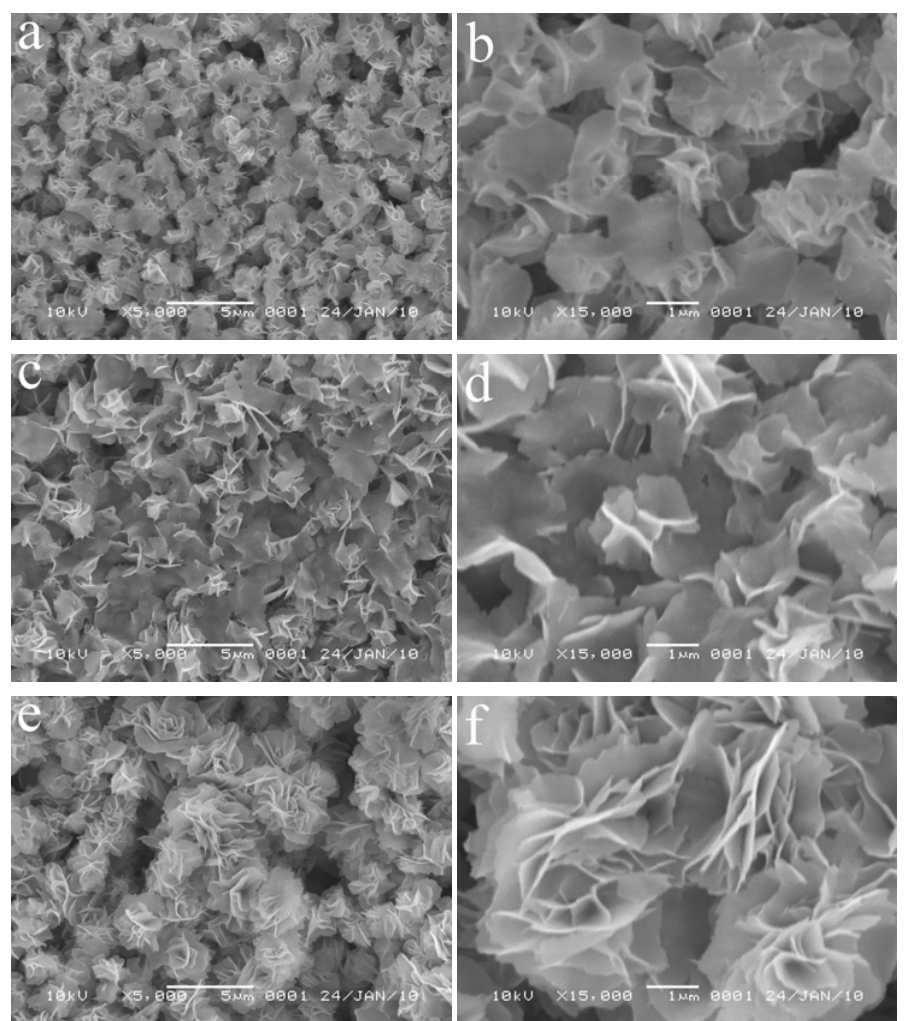
Figure 4. SEM images of the intermediate products reacted at 140 °C for different